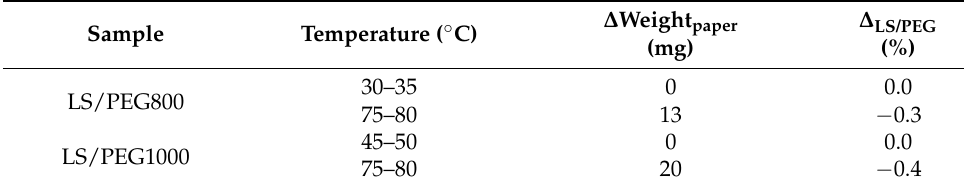
Table 5. Results from leakage tests performed on the composite materials LS/PEG800 and LS/PEG1000 at different temperatures: ∆ Weight paper is the difference in weight of the filter pa- per before and after the permanence of the LS/PEG granules in oven; ∆ LS/PEG is the decrease in weight (in percentage) of the LS/PEG granules at the end of the leakage test. ∆ Weight ∆ paper LS/PEG Sample Temperature ( ◦ C) (mg) (%) 30–35 LS/PEG800 75–80 LS/PEG1000